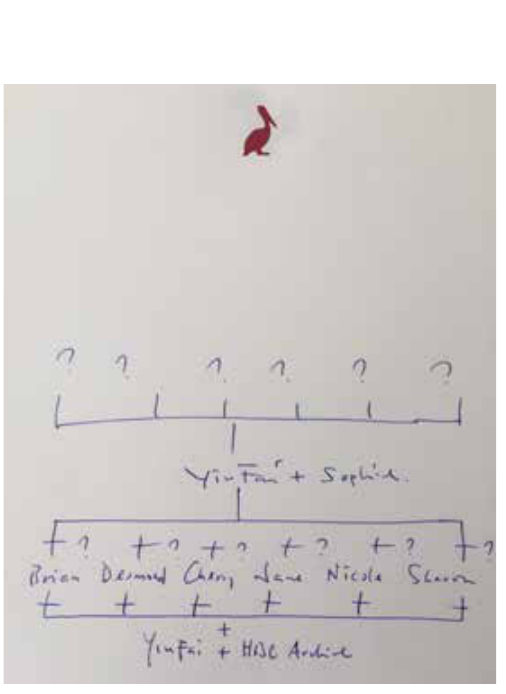
Figure 5: My inverted version of the archival tree. Source: Chow